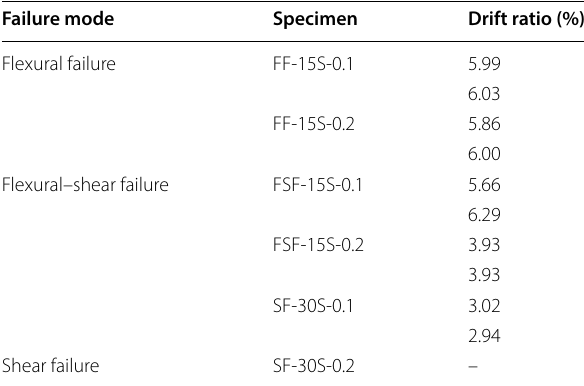
, n , n , n , n , and n . Table 8 Dividing points between the damage levels IV s sp s,max f pf f,max and